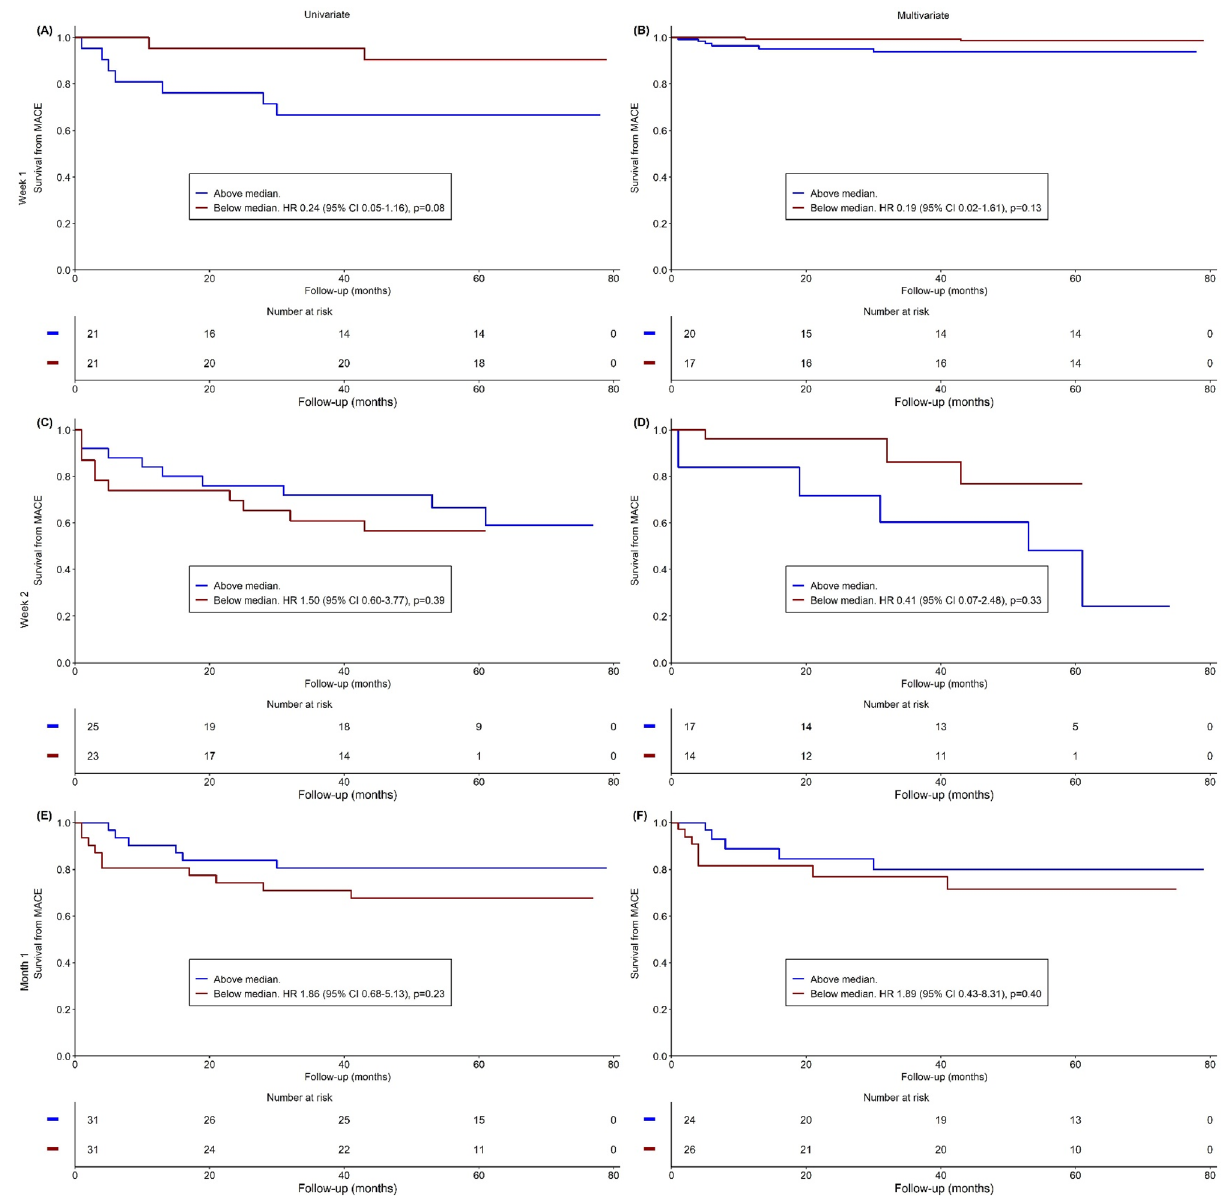
Figure 3. Predictive value of Mon3 for MACE. Univariate (left column) and multivariate (right column) s urvival analyses from MACE in Mon3 according the changes in blood counts of monocyte subsets at one week ( A , B ), two weeks ( C , D ), and one month ( E , F ). MACE Major adverse cardiovascular events, HR Hazard ratio, CI Confidence